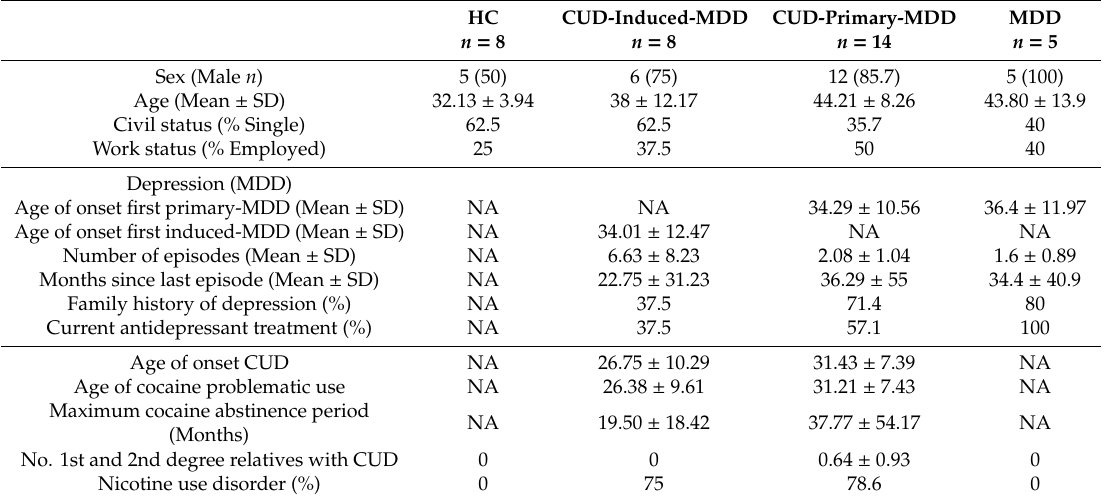
Table 1. Sociodemographic and clinical characteristics of the sample at baseline ( n = 35).